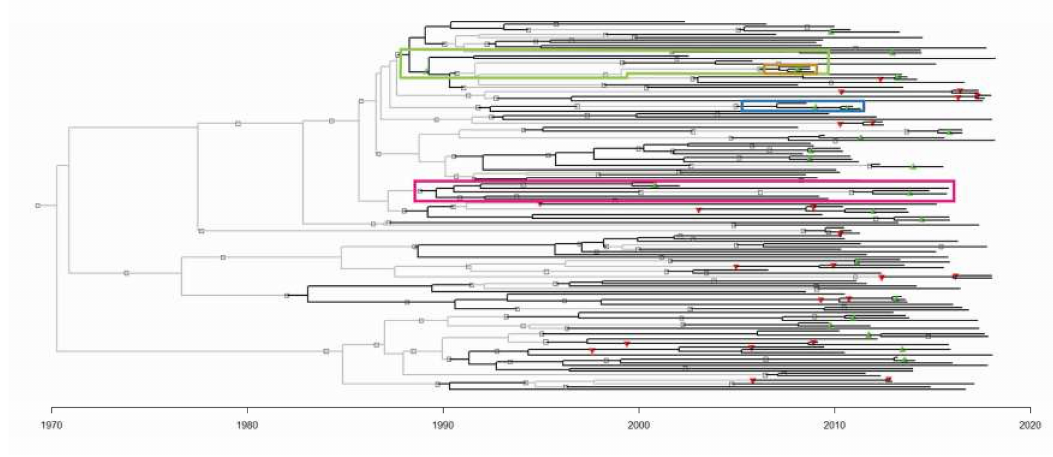
Figure 3. The transmission tree generated by MUSCLE, adjusted BEAST2 parameters, and adjusted TransPhylo parameters. Sampled patients are represented by black branches, and unsampled patients by light grey branches. The symbols represent person-to-person transmission events. Green and red triangles represent correctly and incorrectly inferred relationships respectively. Grey squares represent novel inferences of transmission relationships that have no precedence in the SAC dataset. The branches involved in Figure 4 clusters are highlighted in the correspondingly coloured